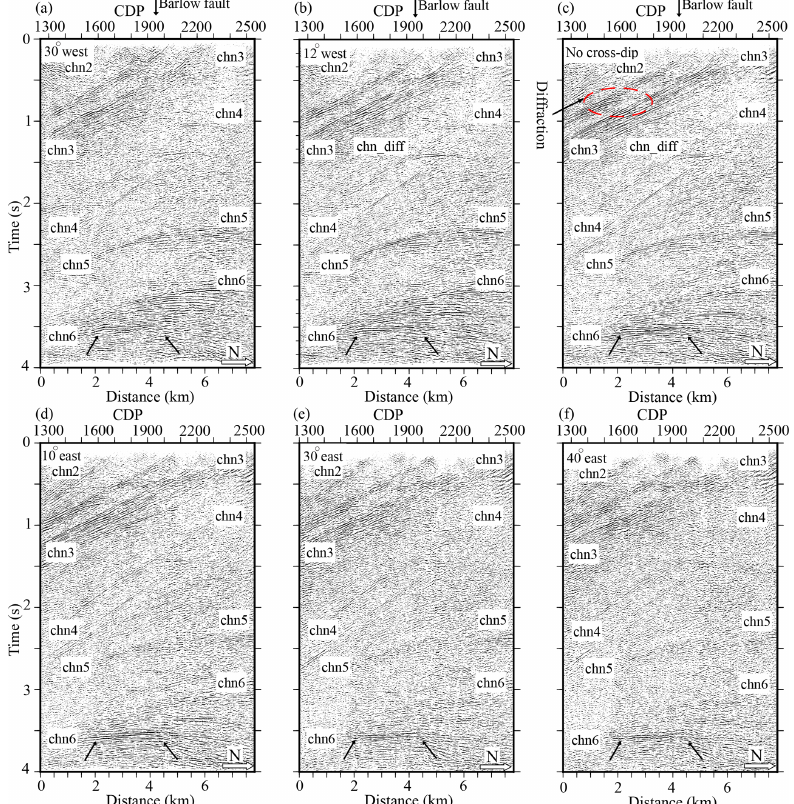
Figure 8. CDMO analysis for the north survey along Sect. 3 (see Fig. 4 for the location of the section). (a) DMO-corrected stacked section with cross-dip element of 30 ◦ to the west applied. (b) DMO-corrected stacked section with cross-dip element of 12 ◦ to the west applied. (c) DMO-corrected stacked section with no cross-dip element applied. (d) DMO-corrected stacked section with cross-dip element of 10 ◦ to the east applied. (e) DMO-corrected stacked section with cross-dip element of 30 ◦ to the east applied. (f) DMO-corrected stacked section with cross-dip element of 40 ◦ to the east applied. See text for the interpretation of marked reflections and diffractions. The surface location of the Barlow fault is presented at the top of the